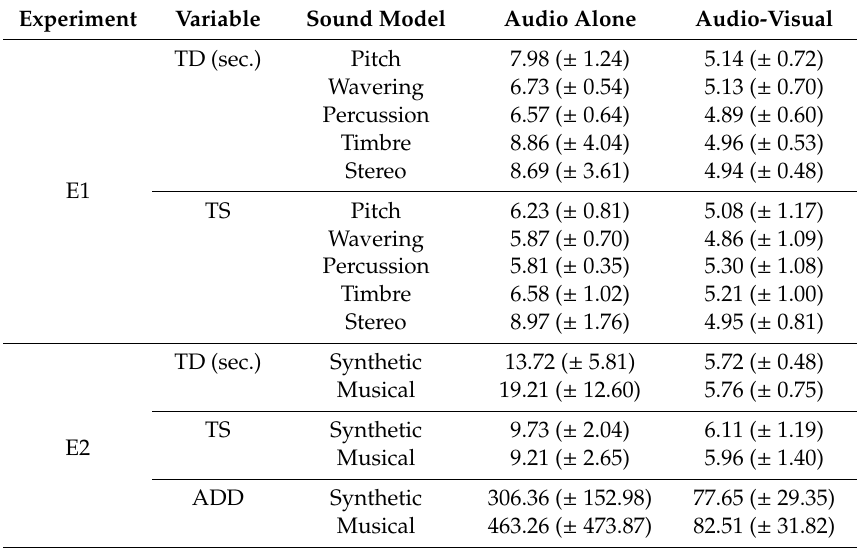
Table 2. Results of movement data in E1 and E2 (mean ( ± standard